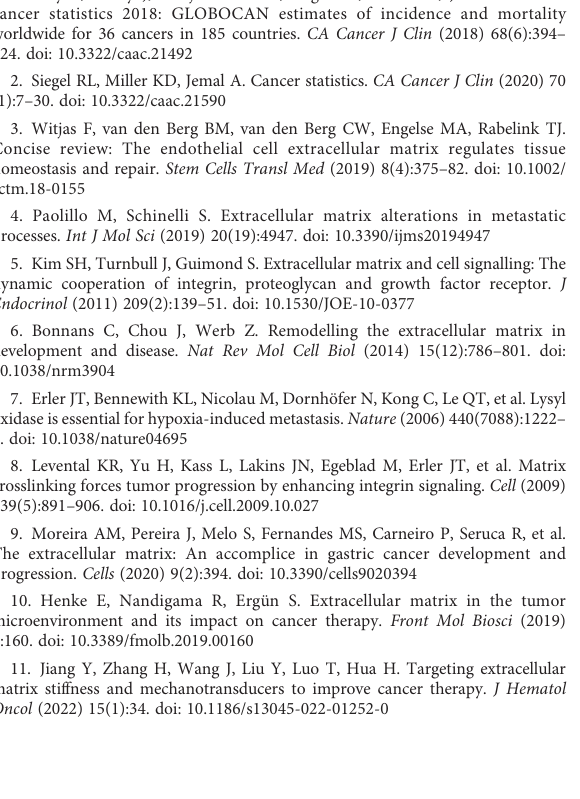
SUPPLEMENTARY FIGURE 1 Analysis of the single-cell types atlas of seven hub ECMGs (A) : COL11A1; (B) : LAMC2; (C) : LAMA3; (D) : LAMB3; (E) : ITGA2; (F) : ITGB4; (G) : ITGB6) related to the prognosis and stage of PAAD by HPA database. SUPPLEMENTARY FIGURE 2 Determination of differentially expressed ECM-associated mRNAs and lncRNAs with prognostic signi fi cance. (A) Identi fi cation of 278 ECM- related lncRNAs. The correlation analysis between 83 ECM-related mRNAs and 278 lncRNAs was performed by Pearson correlation analysis (|R| >0.4 and P<0.01). (B) Univariate Cox regression analysis showed the prognostic values of 149 differentially expressed ECM-related lncRNAs and mRNAs in PAAD. (C) The LASSO coef fi cient pro fi les of ECM-related lncRNAs and mRNAs in PAAD. (D) The cross-validation results of model construction. A total of nine genes were fi ltered by LASSO Cox